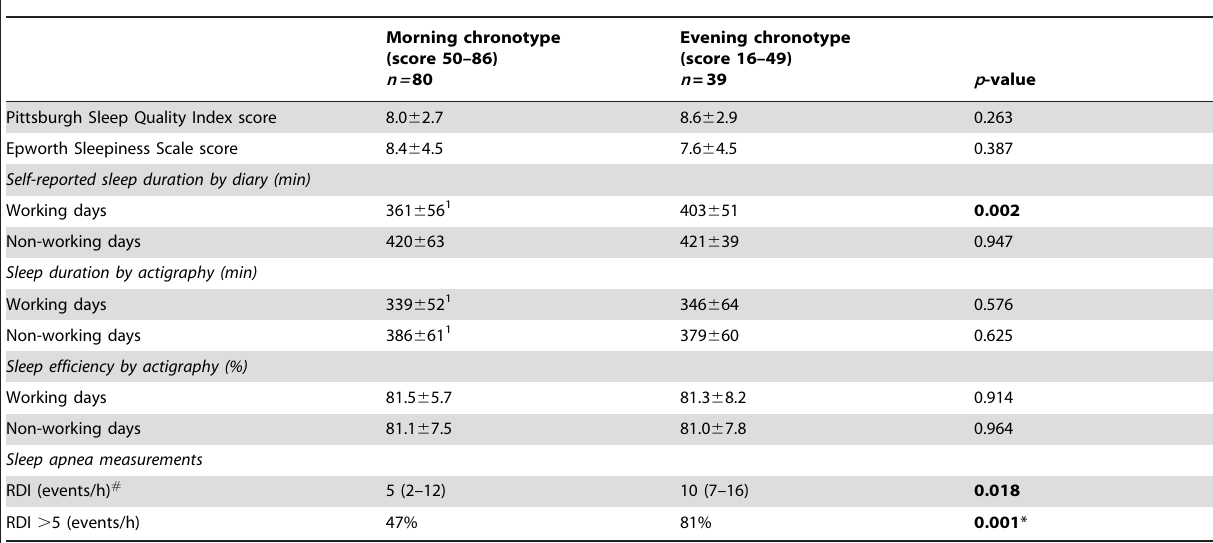
Table 2. Sleep characteristics of study